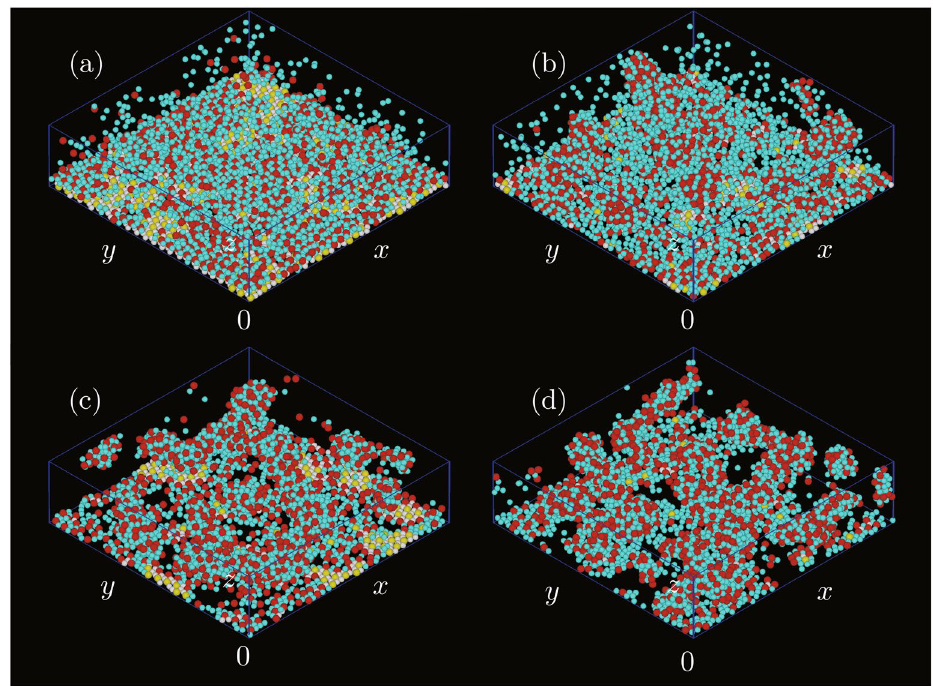
Figure 2. Three-dimensional snapshots of the systems, where ε AA /ε AB and ε BB /ε AB were ( a ) 0.1 and 0.1, ( b ) 0.1 and 0.8, ( c ) 0.8 and 0.1, and ( d ) 0.8 and 0.8. The meanings of the particle colours are the same as those in Fig.